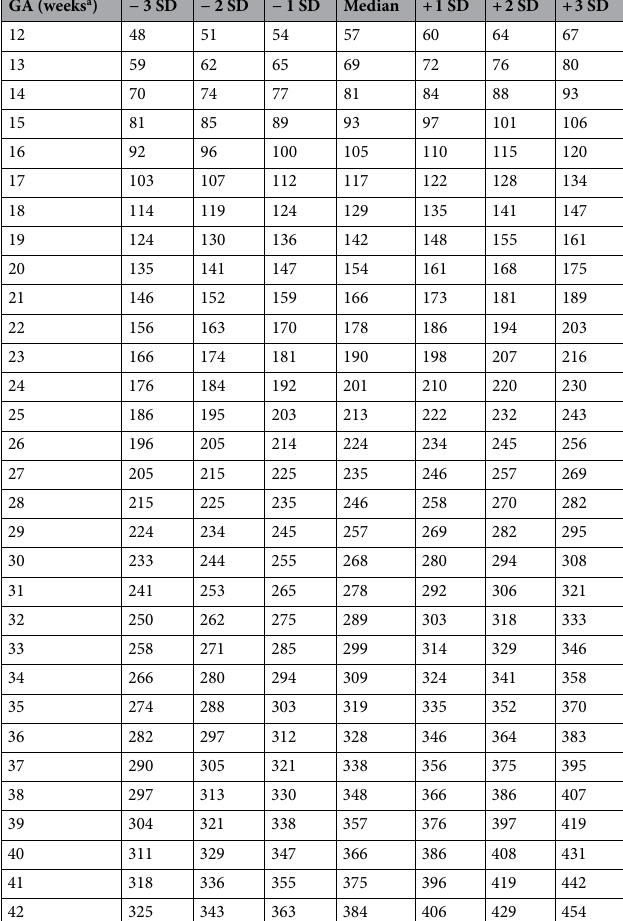
Table 8. Estimated abdominal circumference (AC) in mm by gestational age (GA) for males and females, standard deviations (SD). a GA expressed as completed gestational weeks, e.g. 12 weeks corresponds to 12 + 0 weeks or 84 gestational